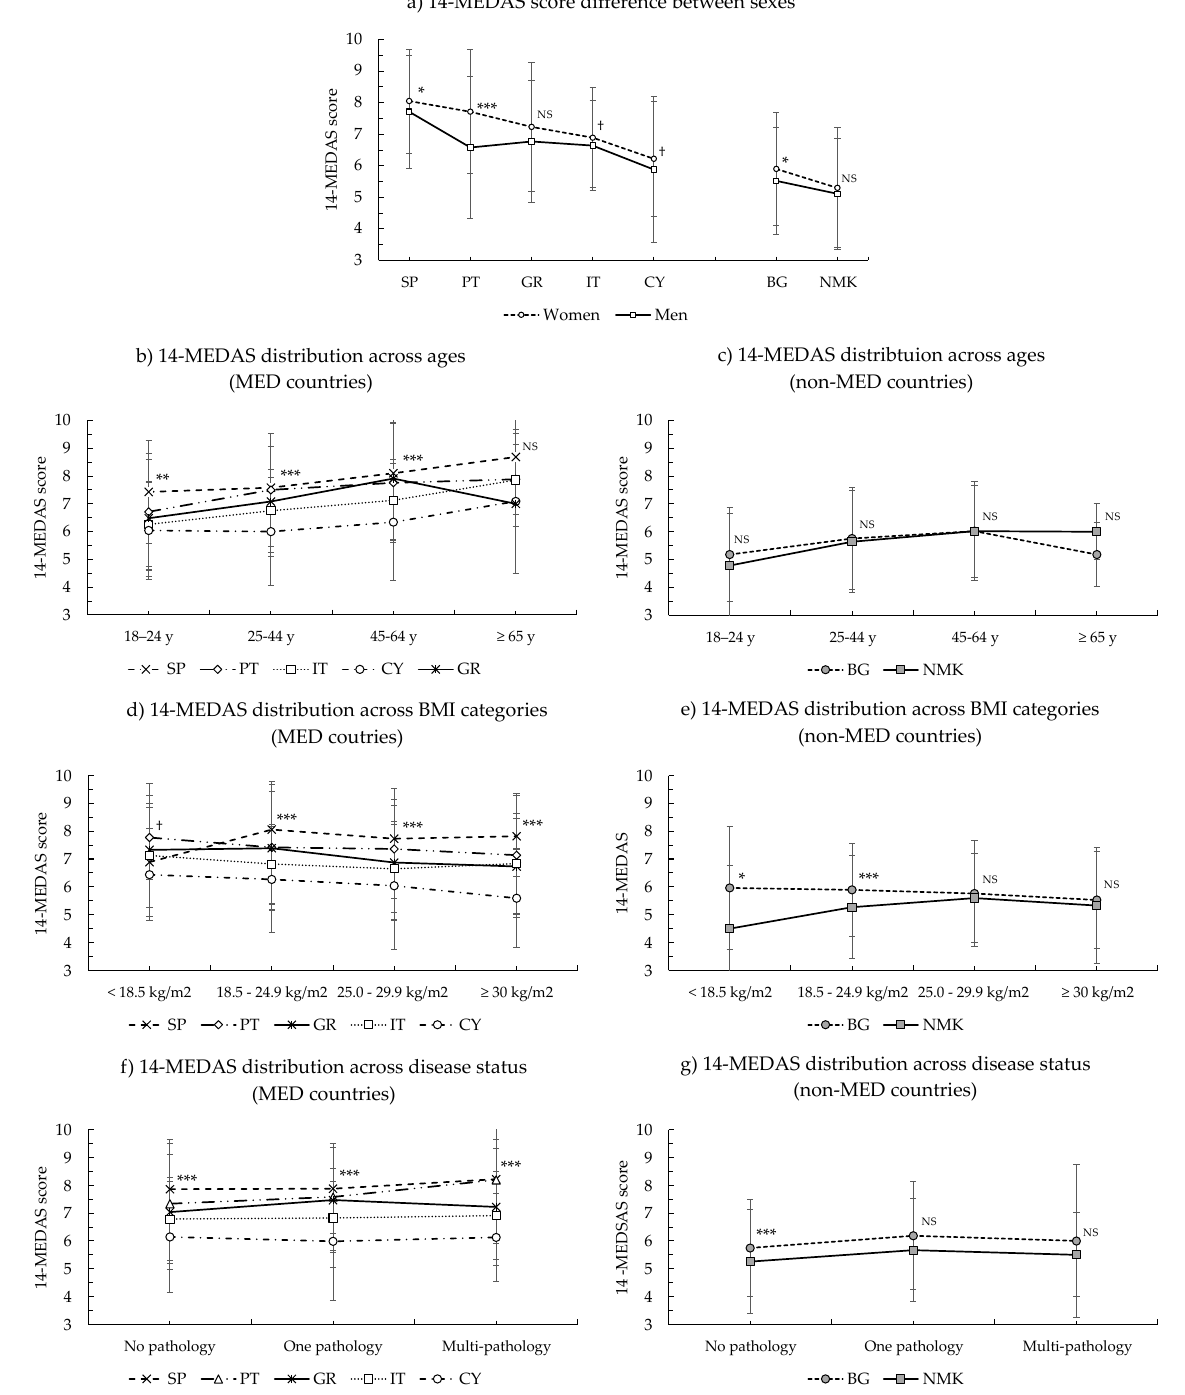
Figure 1. 14-MEDAS score comparative analyses: ( a ) differences between sexes and countries, ( b ) distribution across age ranges in the MED countries, ( c ) distribution across age ranges in the non-MED countries, ( d ) distribution across BMI categories in the MED countries, ( e ) distribution across BMI categories in the non-MED countries, ( f ) distribution across disease status subgroups in the MED countries, ( g ) distribution across disease status subgroups in the non-MED countries. PT: Portugal; SP: Spain; IT: Italy; GR: Greece; CY: Cyprus; BG: Bulgaria; NMK: Republic of North Macedonia; MED: Mediterranean countries; Non-MED: non-Mediterranean countries. NS: not significant; † p -value < 0.1; * p -value < 0.05; ** p -value < 0.01; *** p -value < 0.001 significant differences between sexes in ( a ) and between countries in ( b – g ).